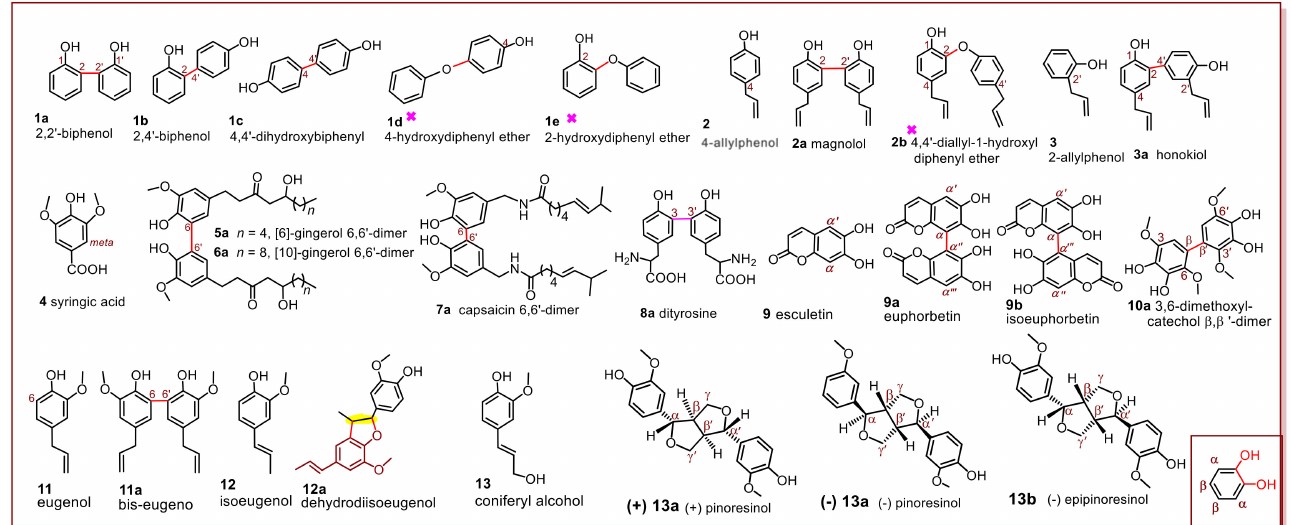
Figure 1. Structures of some phytophenols mentioned in Table 1. (The absolute